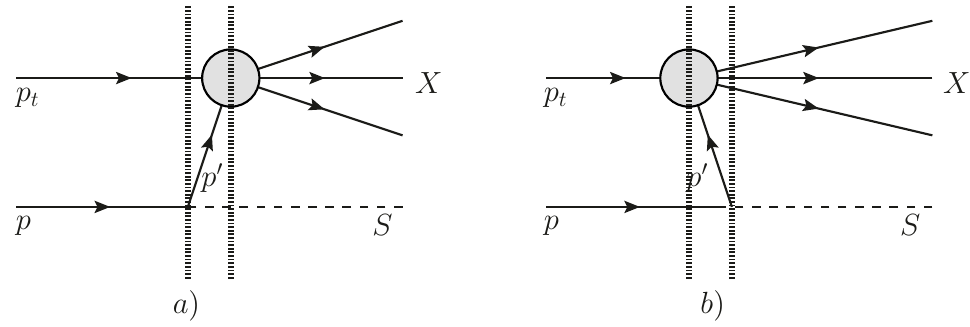
Figure 18 . The lowest order old-fashioned perturbation theory diagrams for the bremsstrahlung process (D.1). Vertical dotted lines denote the intermediate